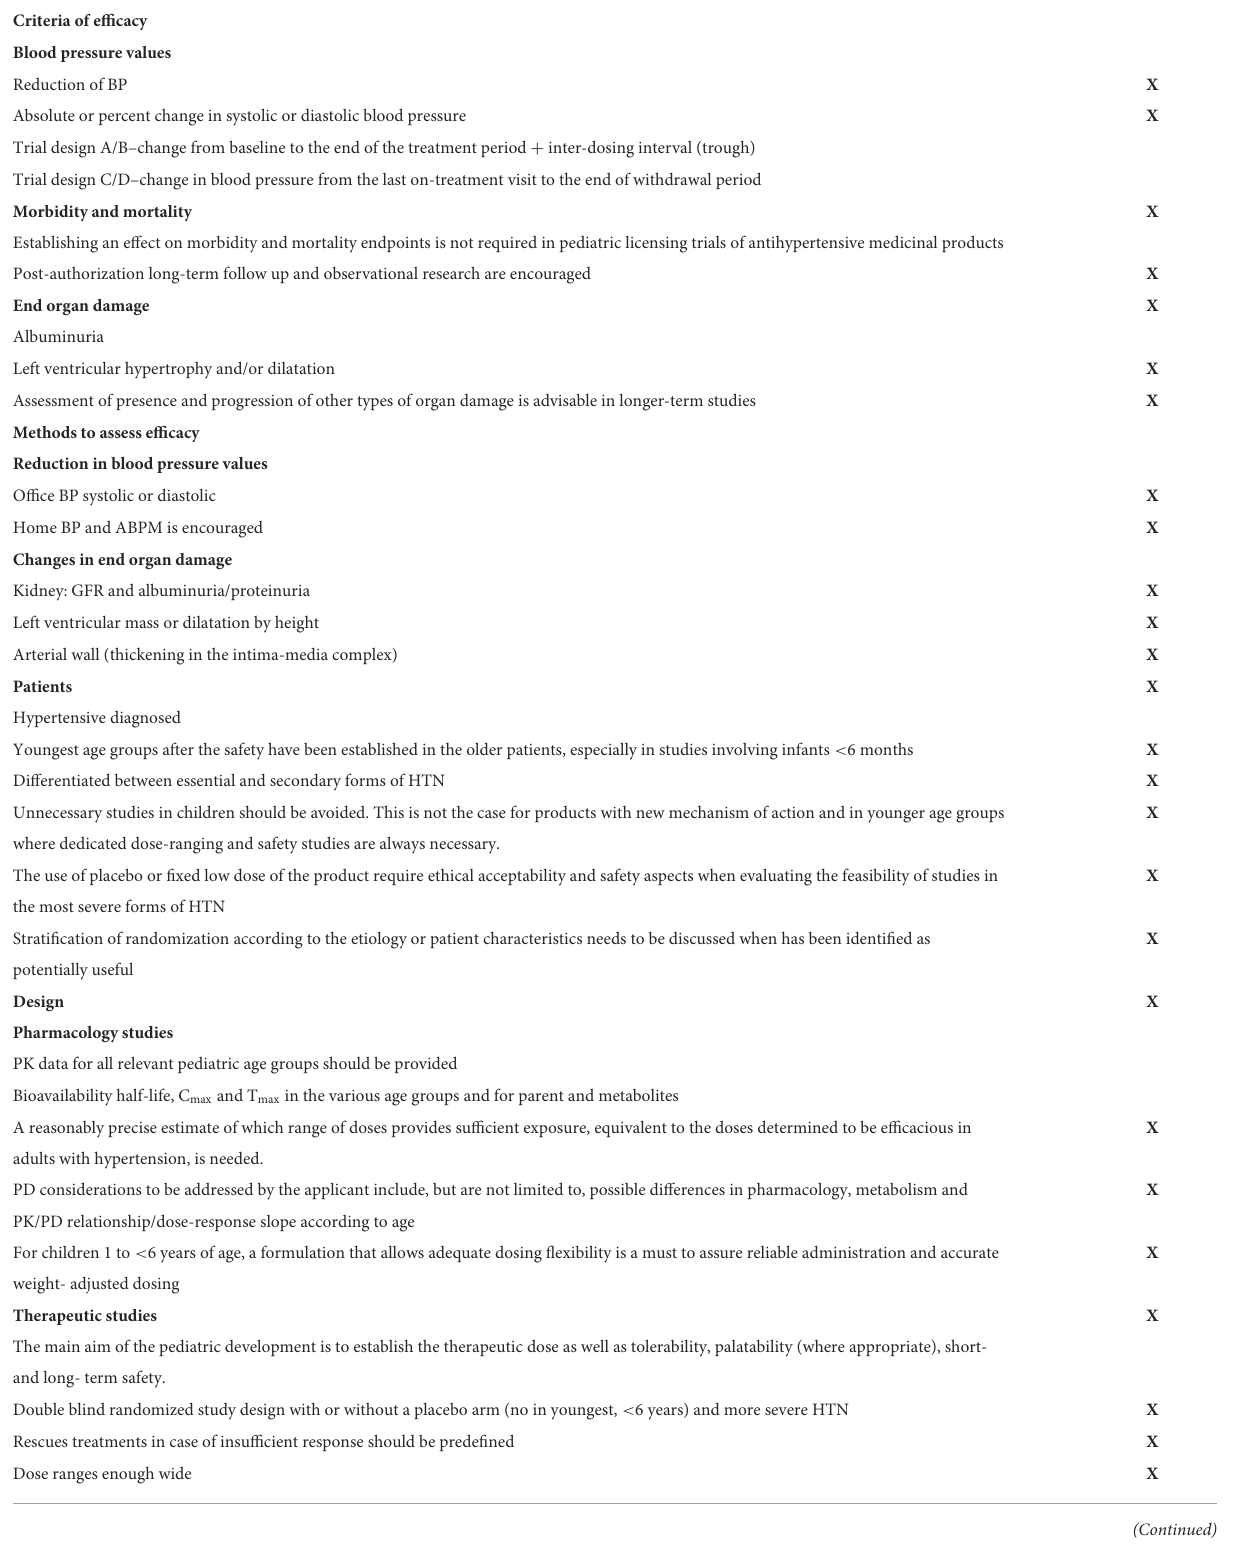
TABLE 1 Criteria for the methods to establish dosing recommendation and safety of antihypertensives from EMA